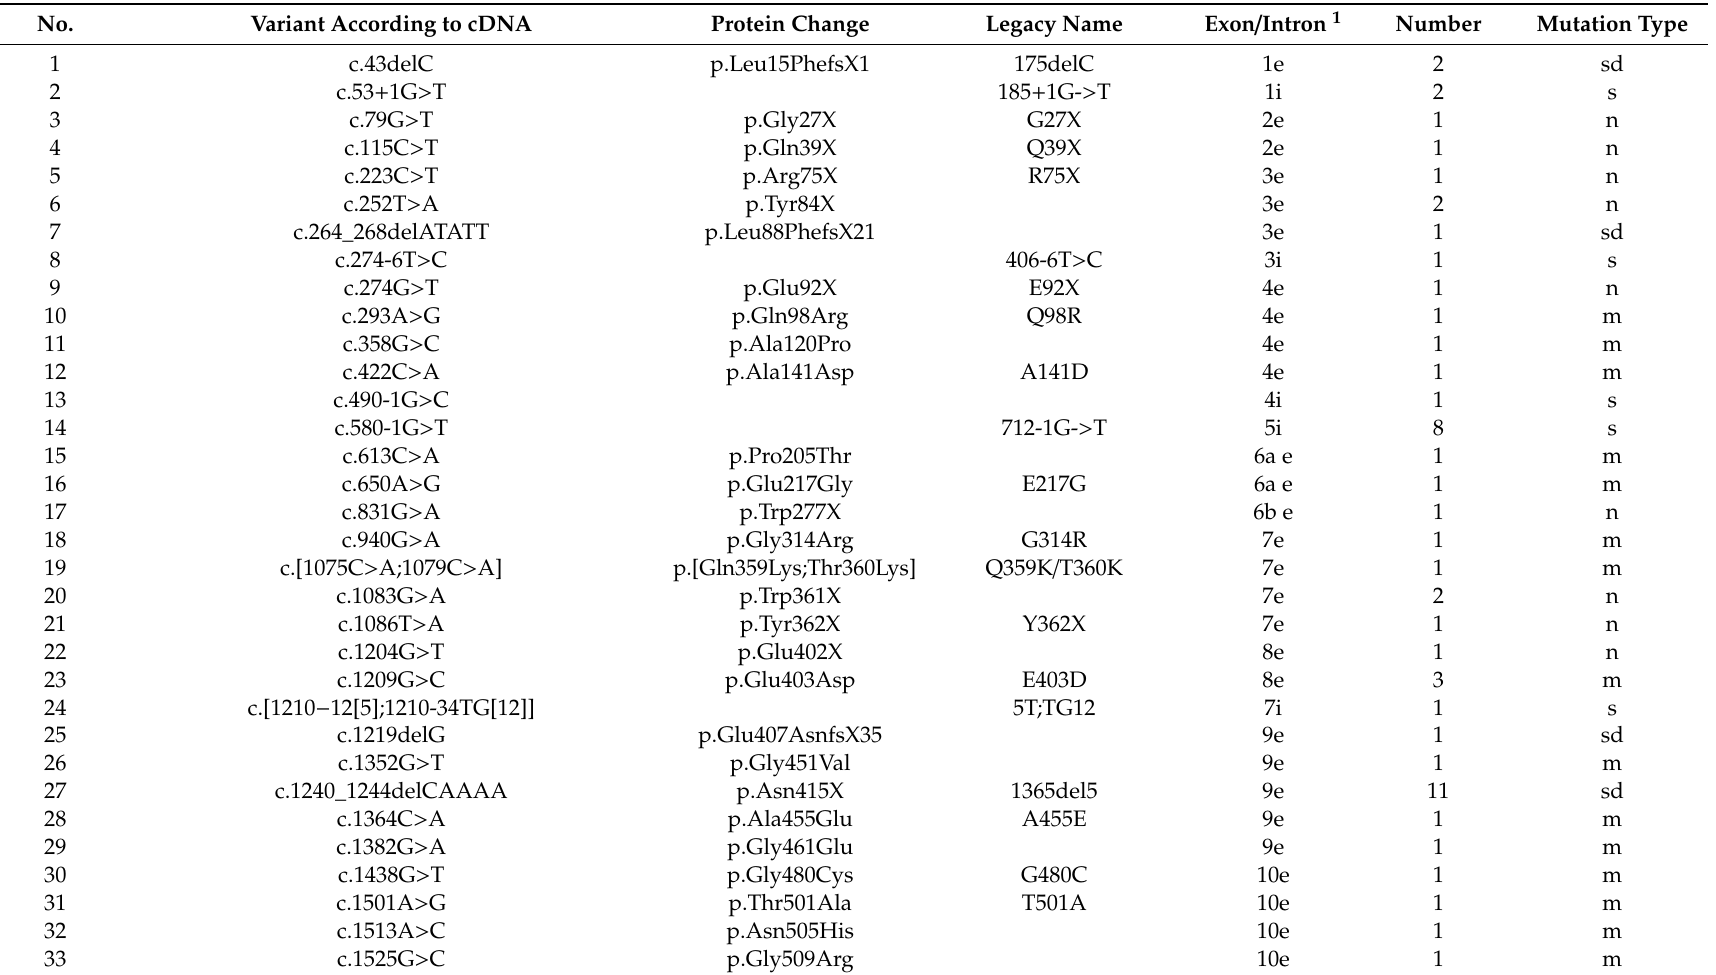
Table 2. The CFTR gene variants additionally identified in 154 previously screened Russian